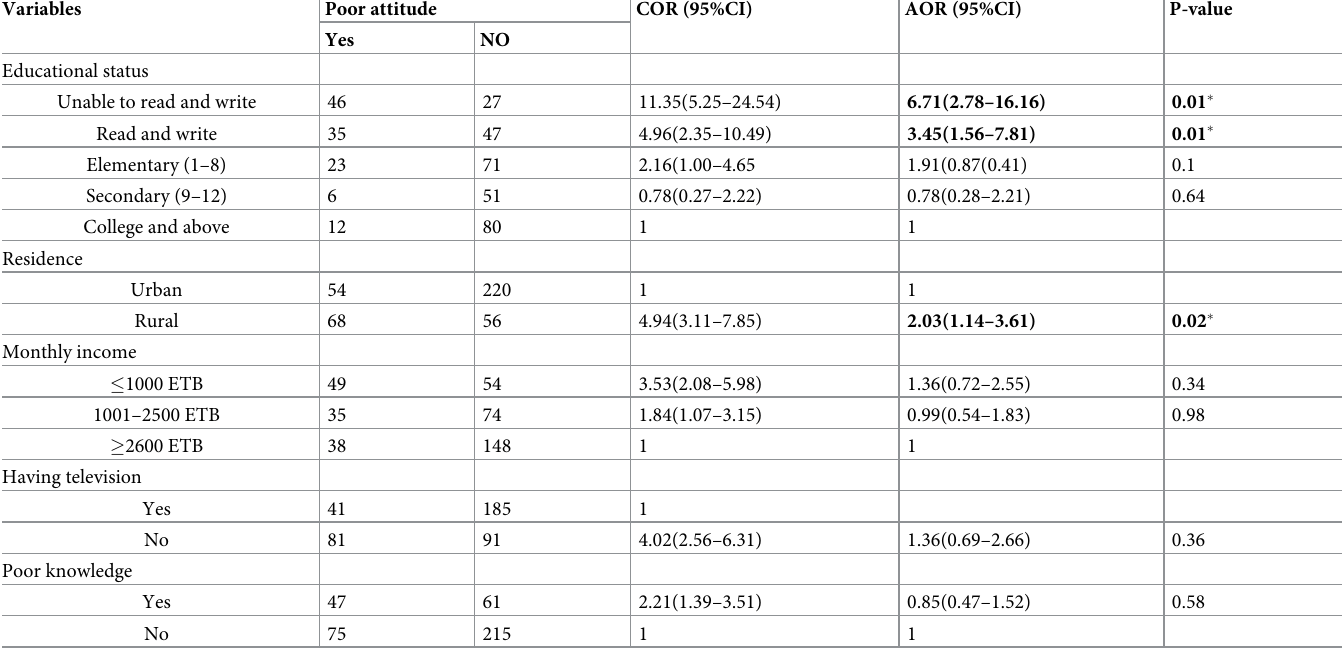
Table 5. Factors associated with a poor attitude among outpatient service visitors at Debre Markos comprehensive specialized hospital, Amhara regional state, Ethi- opia,